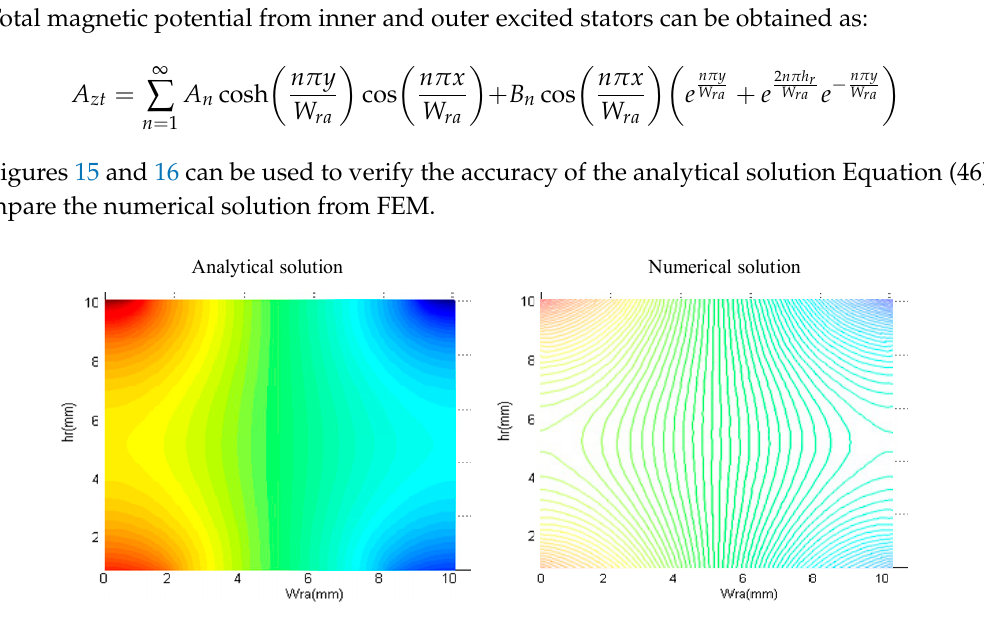
Figure 15. Comparison of the 2D total magnetic potential vector between analytical solution and numerical solution from FEM.